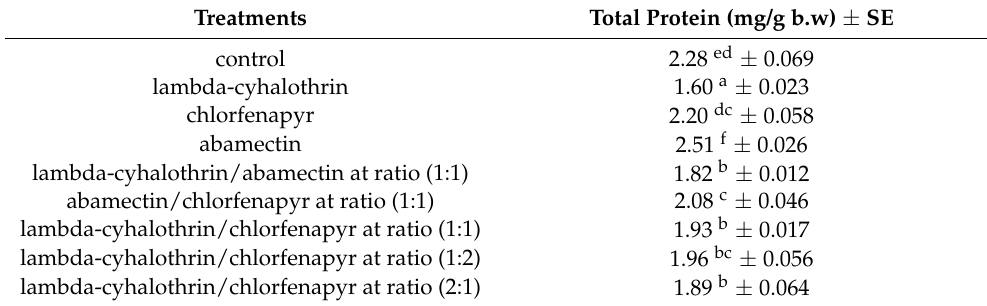
Table 2. Total protein in the laboratory strain of larvae M. domestica treated with pesticides alone and combination.